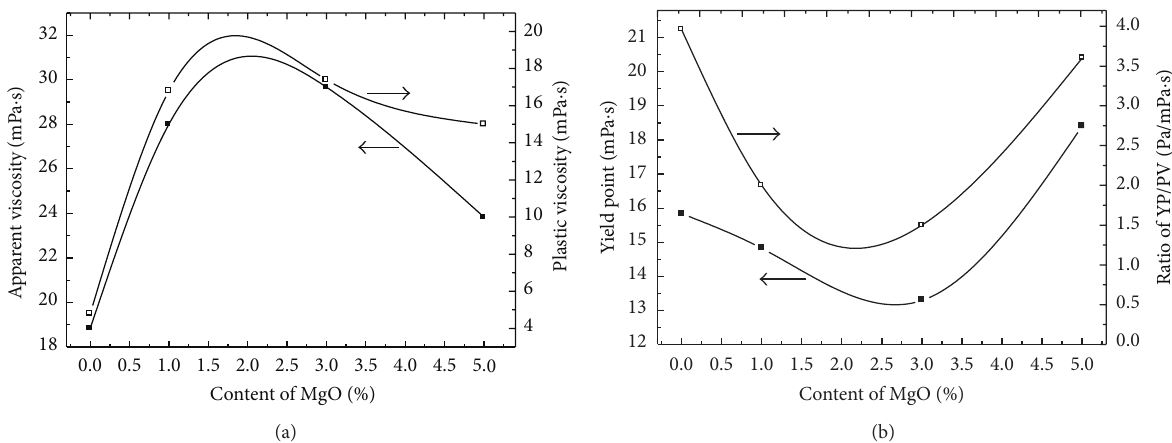
Figure 5: The effects of MgO on the rheological parameters of palygorskite suspension. (a) The apparent viscosity and plastic viscosity of palygorskite suspension. (b) The yield point and ratio of YP/PV of palygorskite suspension.